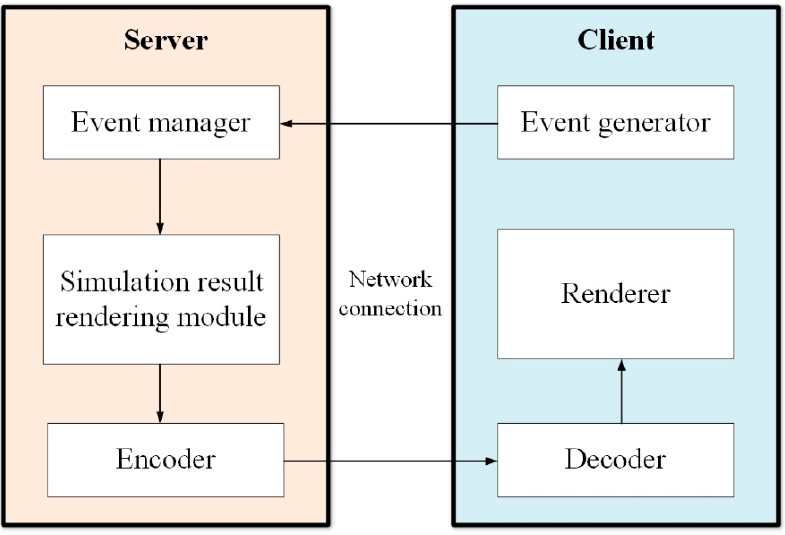
Figure 6. Client-server system for engineering analysis and simulation [98].